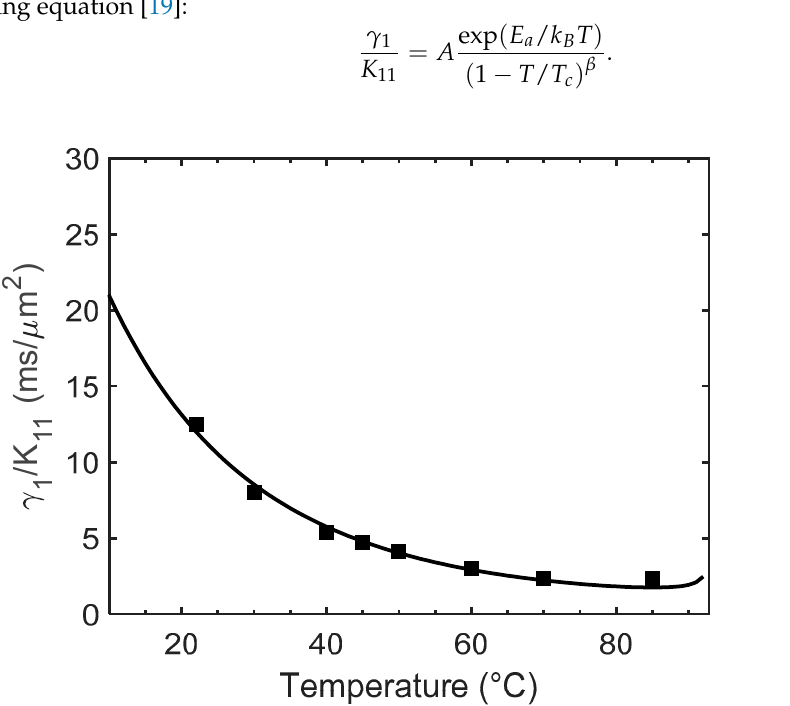
Figure 3. Temperature-dependent viscoelastic constant of DIC A4907. Squares are measured data and solid line is fitting curve with Equation (3).